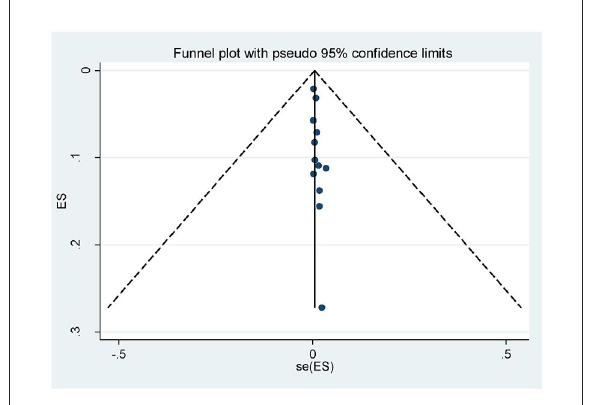
FIGURE3 Funnel plot for pooled prevalence of operative vaginal deliveries among mothers in Ethiopia,